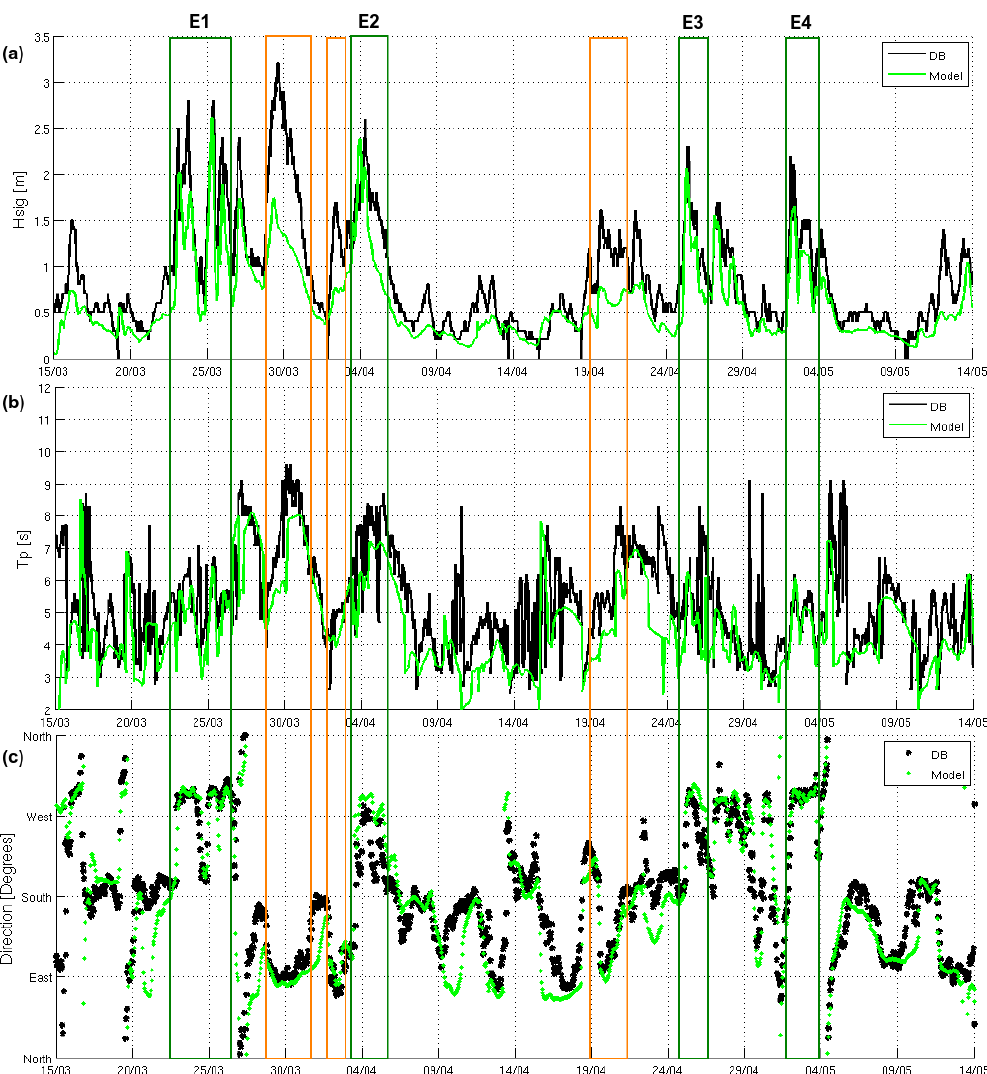
Figure 4. Comparison between model results (green) versus observed data at DB (black): ( a ) significant wave height, ( b ) peak period and ( c ) nautical direction. The green boxes are the selected wind-jet events, and the orange boxes are the most underestimated events, which match easterly wind events. Time series data are for